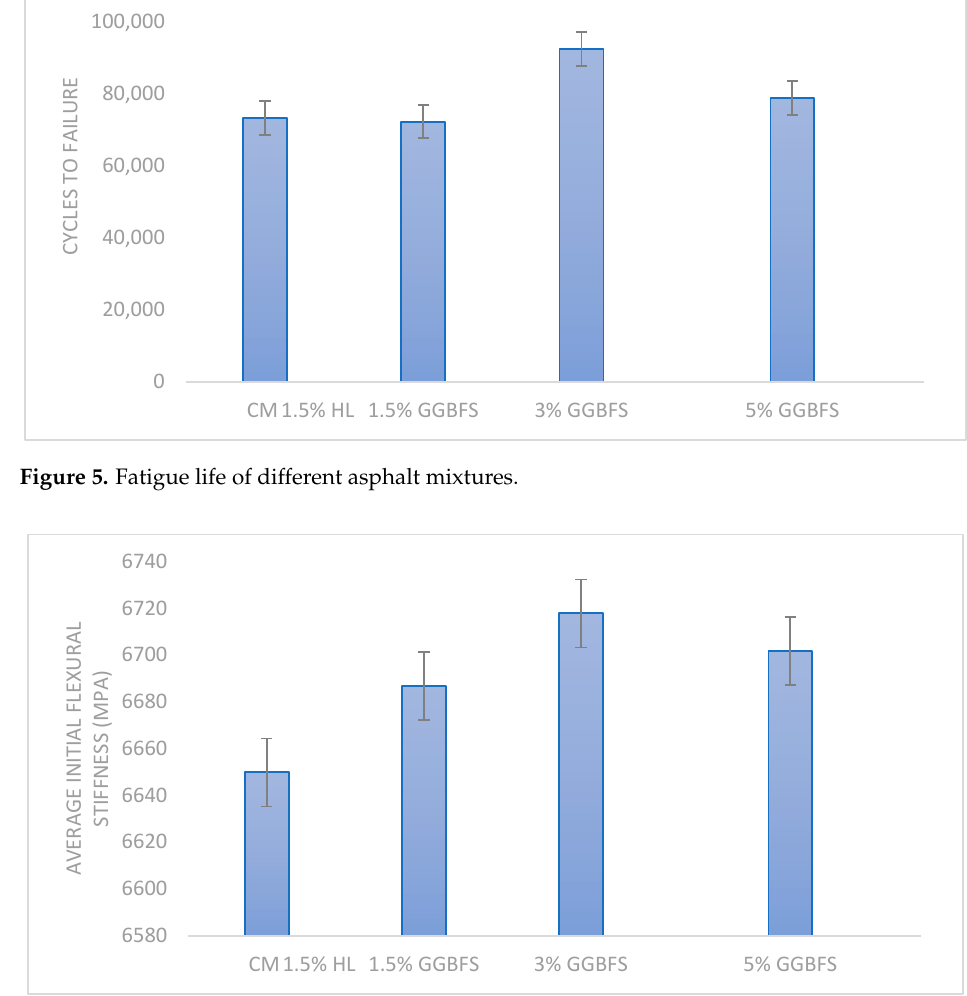
Figure 6. Comparison of the initial flexural stiffness of different asphalt mixtures.